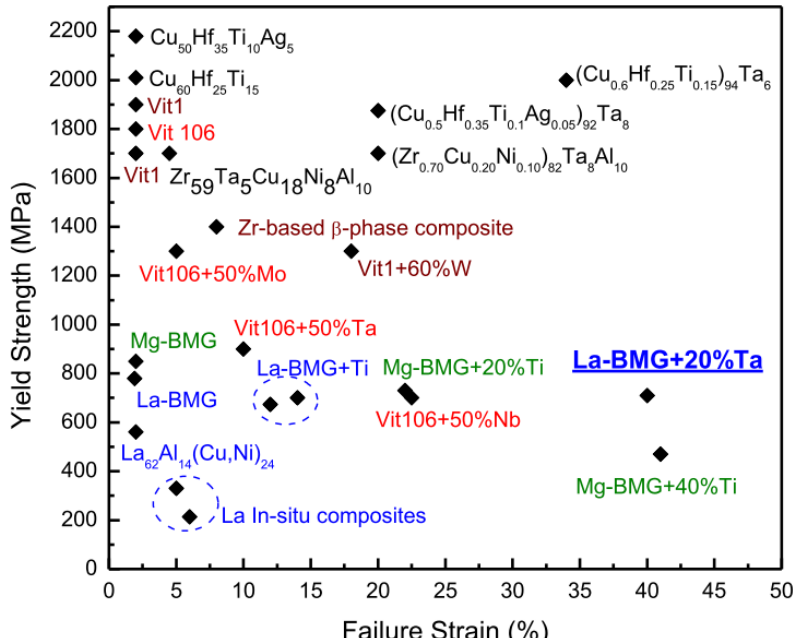
Figure 5. A chart comparing the yield strength and failure strain of various BMG composites. The compositions and the references wherefrom the data are taken are as follows—Vit1: (Cu Hf Ti ) Ta [8]; (Cu Hf Ti Ag ) Ta [9]; (Zr Cu Ni ) Ta Al [7]. 0.6 0.25 0.15 94 6 0.5 0.35 0.1 0.05 92 8 0.7 0.2 0.1 82 8 10 La-BMG: La Al Cu Ni ; Mg-BMG: Mg Cu Gd [11]. In general, the in situ 55 25 10 10 65 25 10 composites show toughening, but with a large reduction in strength. The current composite, La-BMG + 20% Ta appears to possess the best combination of strength and plasticity among all La-based composites and even surpasses some of the Vit106-based ex situ